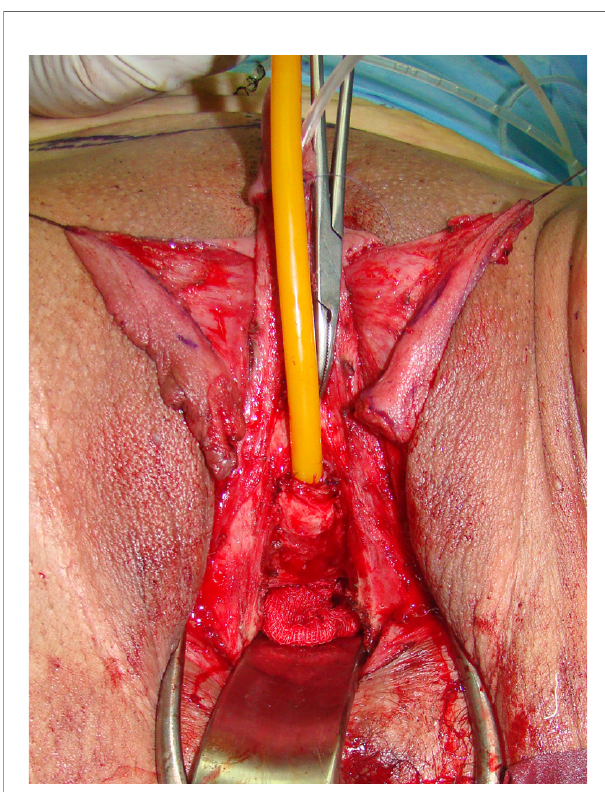
FIGURE 5 | Bulbar part of the neourethra is created and covered with bulbar muscles.